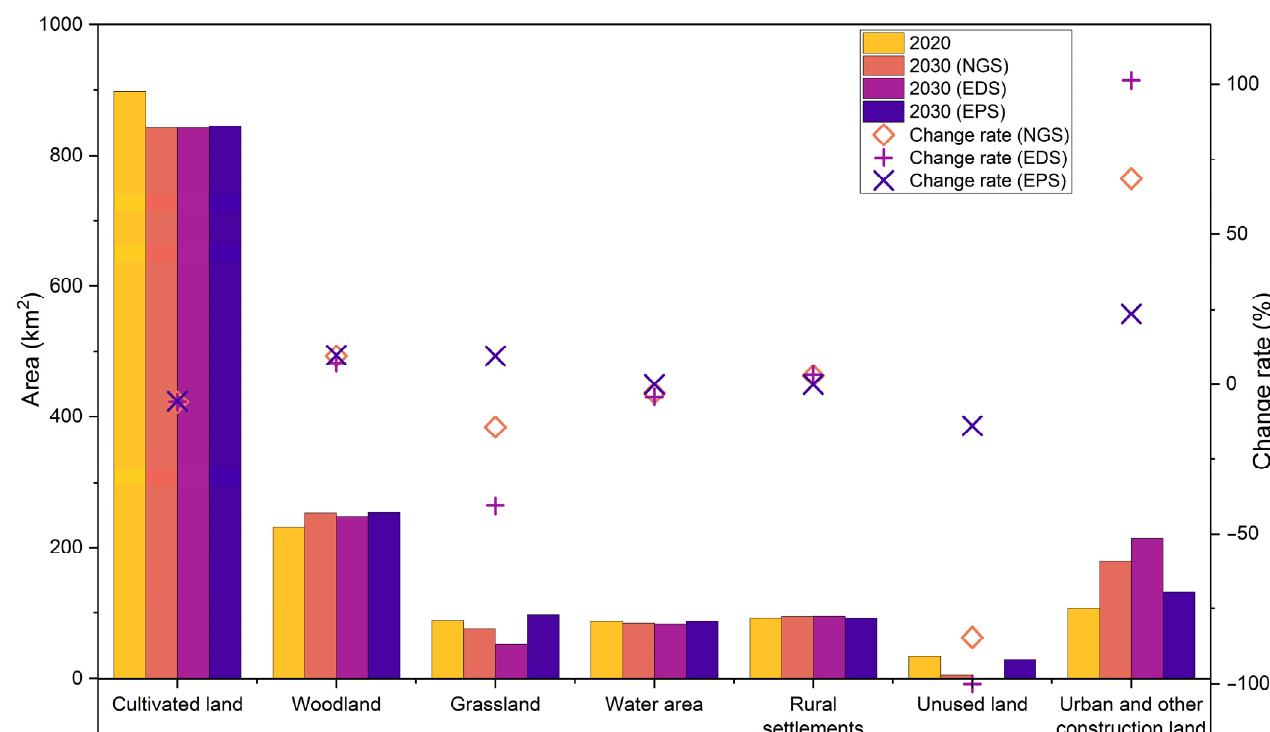
Figure 6. Land use changes under di ff erent scenarios for 2030.